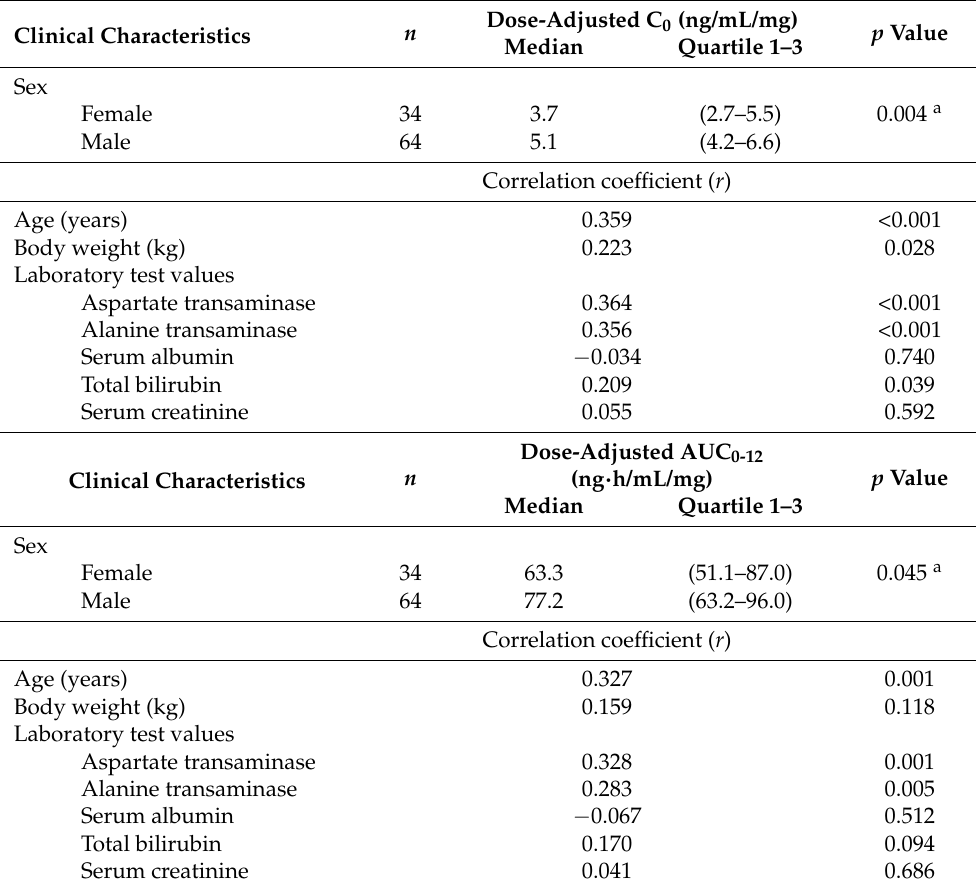
Table 3. Comparison of everolimus dose-adjusted C 0 and AUC 0-12 values and clinical characteristics of patients.